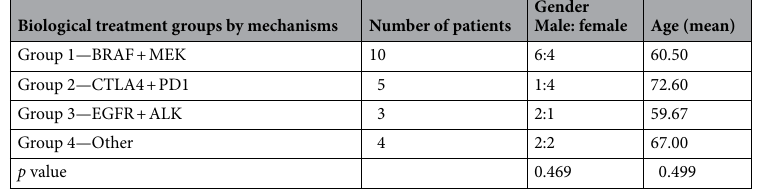
Biological treatment groups by